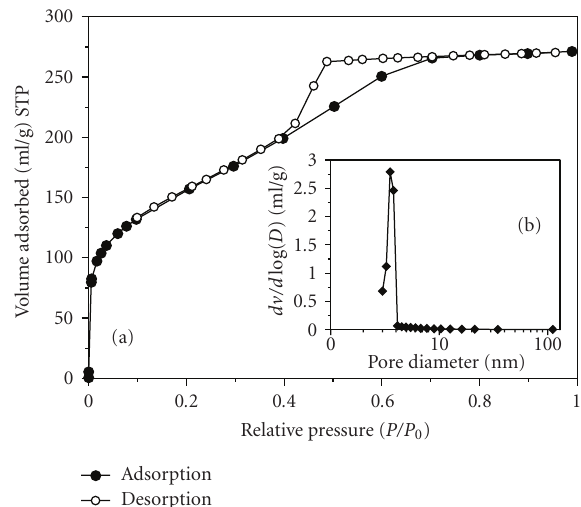
Figure 3: N 2 adsorption-desorption isotherms (a) and pore-size distribution (b) of SiO 2 powder obtained from sol-gel